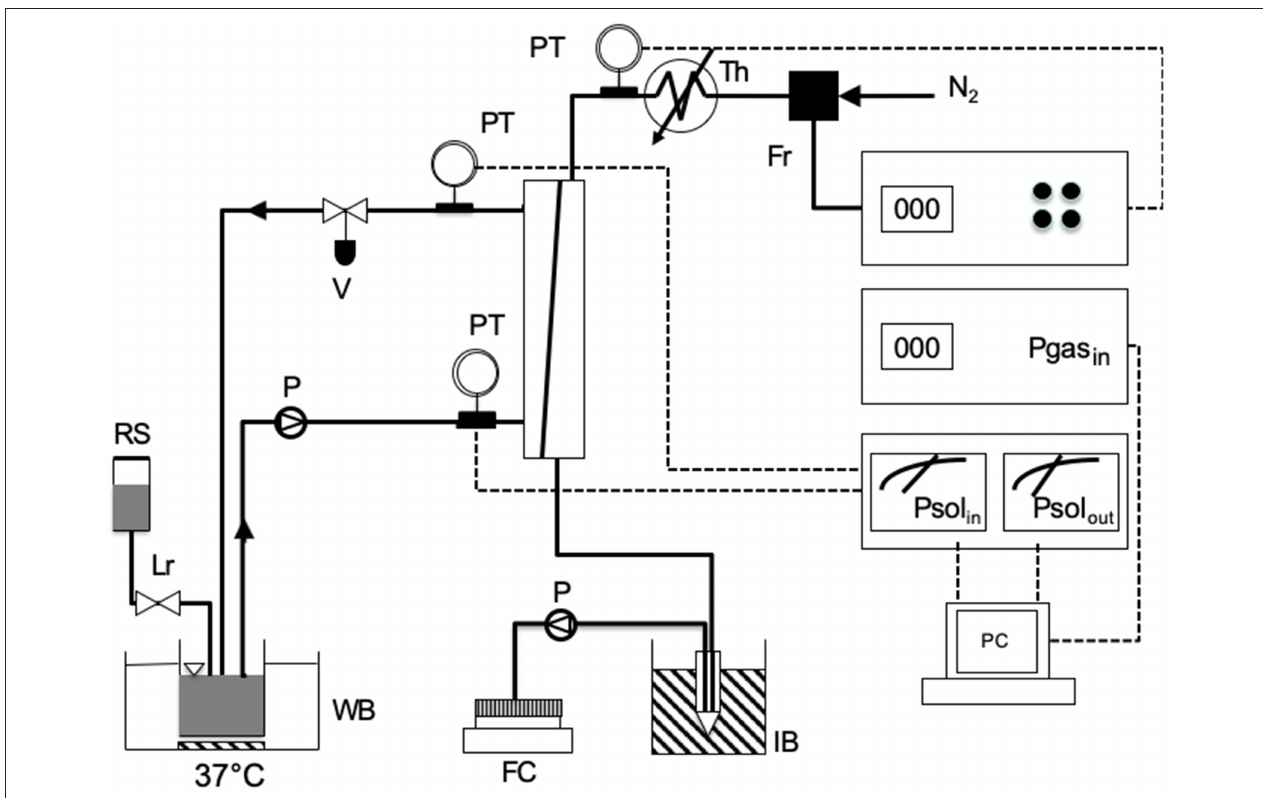
FIGURE 1 | Scheme of the experimental apparatus used for testing the resistance to water breakthrough of modules equipped with the investigated membranes: FC, fraction collector; FR, flow controller of gas stream; IB, ice bucket; LR, level controller; P, pump; PC, personal computer; PT, pressure transducer; RS, reservoir with solution; TH, thermostat for gas heating; WB, thermostated water